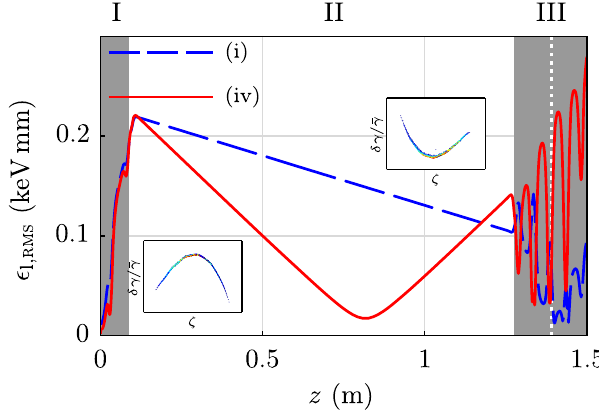
11. Comparison of the longitudinal RMS emittance for case (i) and case (iv), resulting from A STRA simulations. For case (i), space charge was not included, and only the second order is eliminated, while case (iv) is tracked including space charge and aimed for a minimization of second and third order correlations in the focus. As can be seen, there is a minimum of the emittance in between gun and buncher cavity for case (iv), where the second order changes sign, which is illustrated by the insets showing the longitudinal phase space before and after the minimum; the linear correlation has been subtracted for demon- stration purposes. Without this overcompensation mode — as in case (i) — a minimization of the third order is